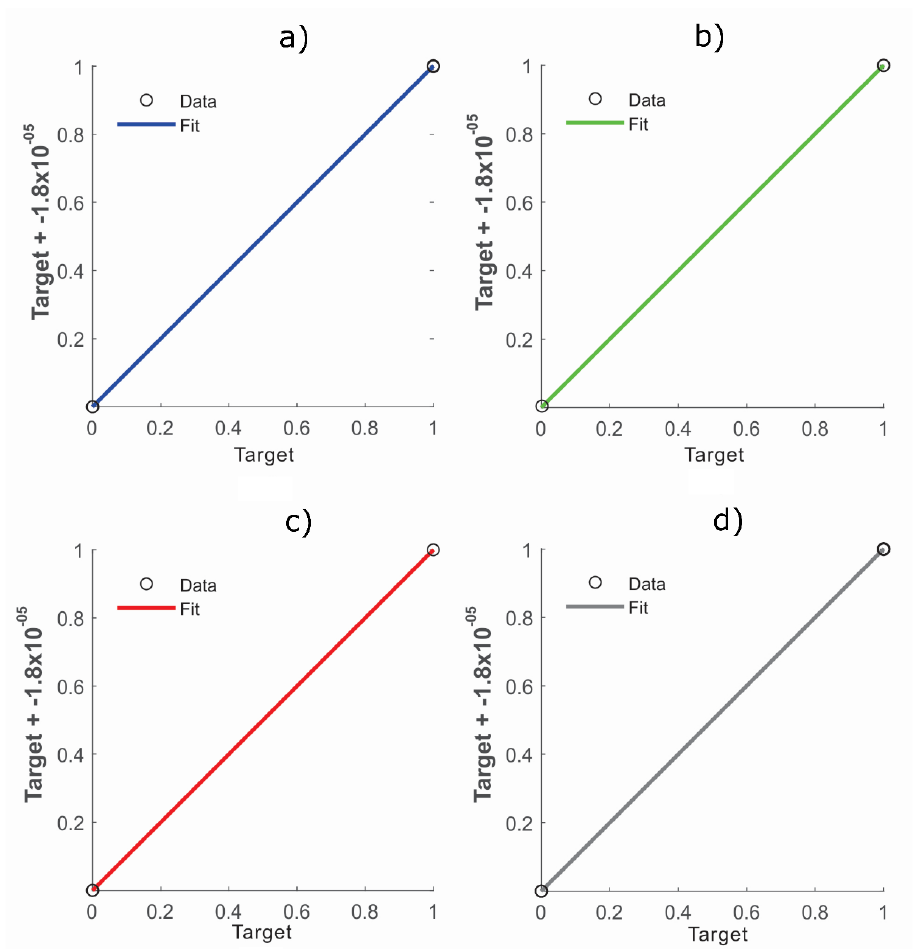
Figure 7. Neural network training system using 80 input data (ns): ( a ) training, ( b ) validation, ( c ) test, and ( d ) all parameters. 277